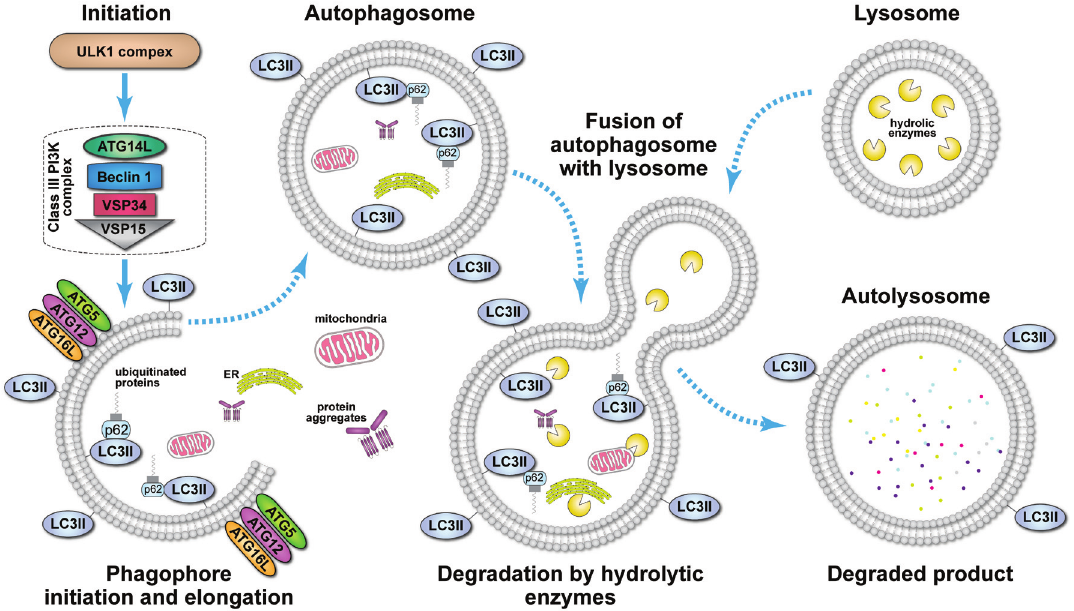
Figure 1. Process of autophagy. Initiation of the autophagy process is mediated by the ULK1 complex in response to various cellular signals. Formation of the phagophore also requires class III phosphoinositide 3-kinase (PI3K) complex, which is composed of VPS34 (vacuolar protein sorting 34) PI3K, ATG14L, VPS15, and beclin 1. The ATG5-ATG12-ATG16 complex and LC3II promote the elongation of the phagophore and are required for the formation of the autophagosome. p62 bound to ubiquitinated proteins targeted for degradation binds to lipidated microtubule-associated protein light chain 3 (LC3II) during the formation of the autophagosome as intracellular materials are engulfed into the forming autophagosome. Subsequently, the autophagosome fuses with a lysosome, which delivers hydrolytic enzymes for the degradation of the engulfed intracellular